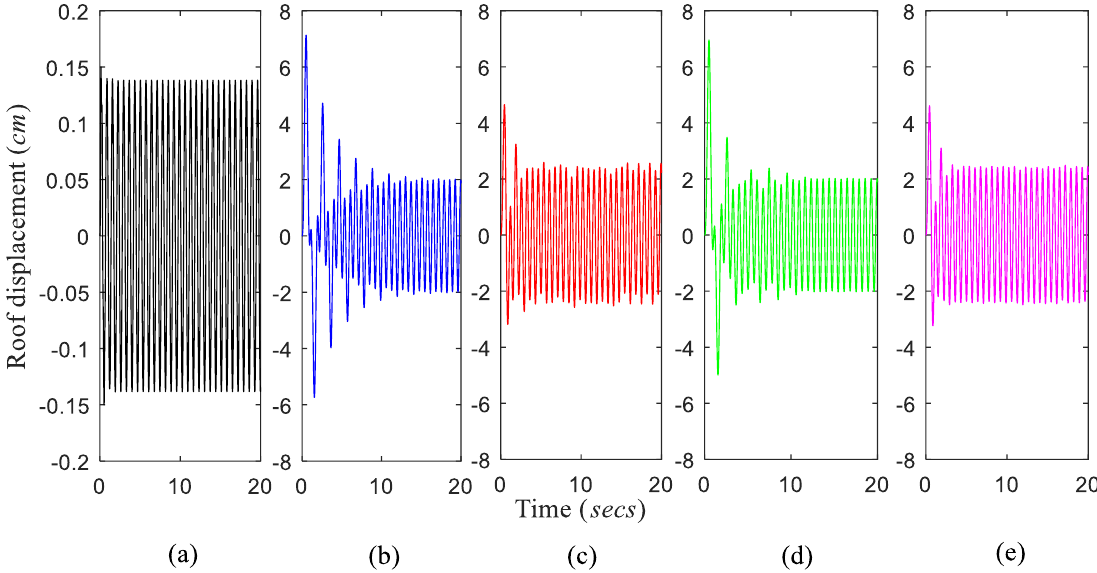
Fig. 13. Time history of roof displacement of (a) Fixed base (b) Isolated base with LRB (c) Isolated base with LPB (d) Isolated base with LRB and TMD (e) Isolated base with LPB and TMD structures under wind load causing yielding of